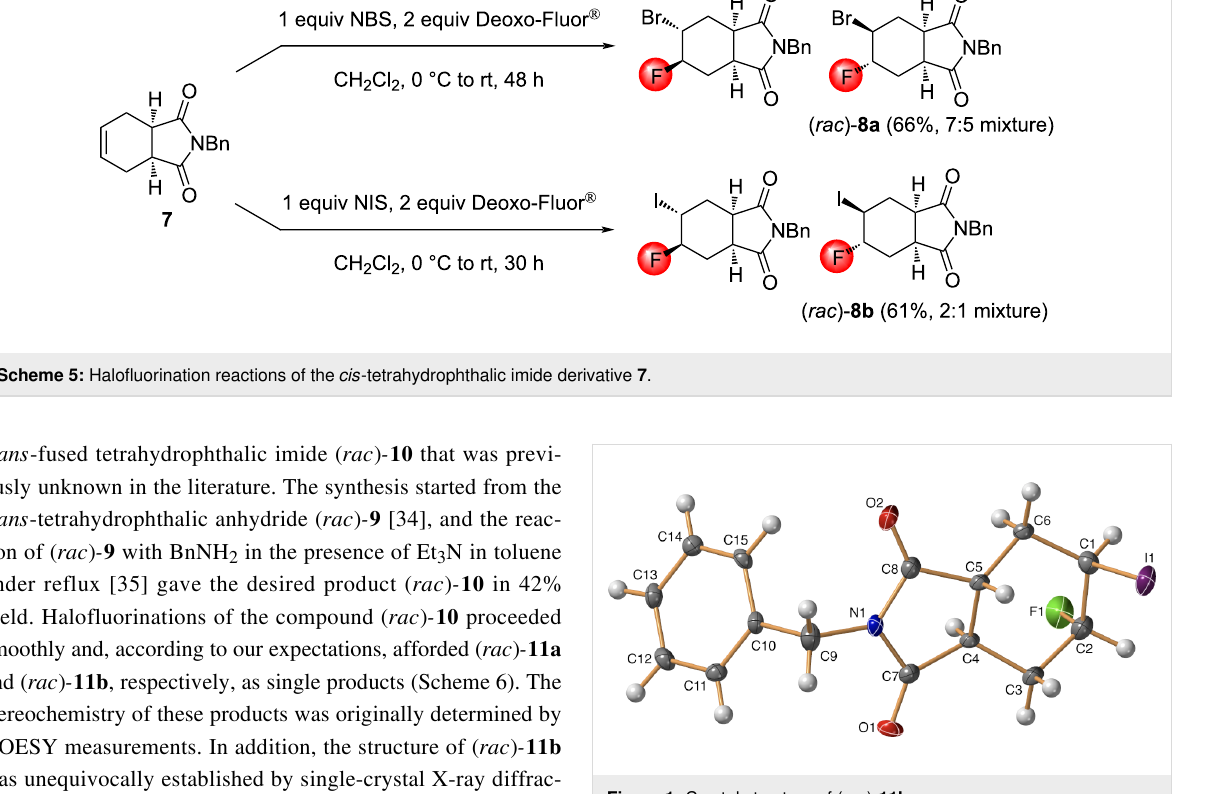
Figure 1: Crystal structure of ( rac ) - 11b .